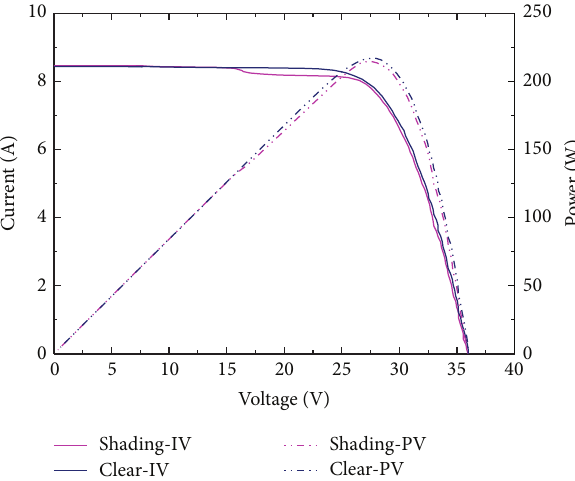
Figure 7: The I-V and P-V characteristics of the module before and after the plant removal.